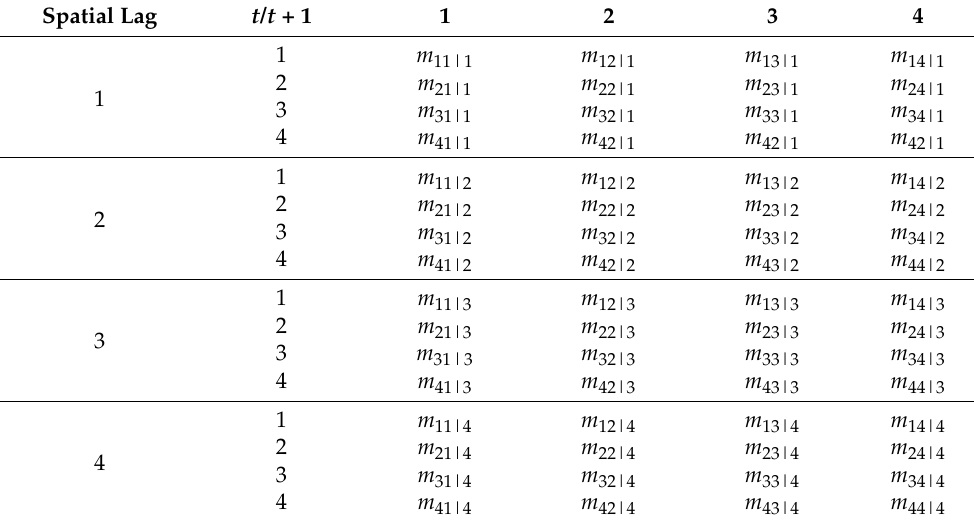
Table 4. Spatial Markov transition probability matrix n ( k = 4). Spatial Lag t / t +